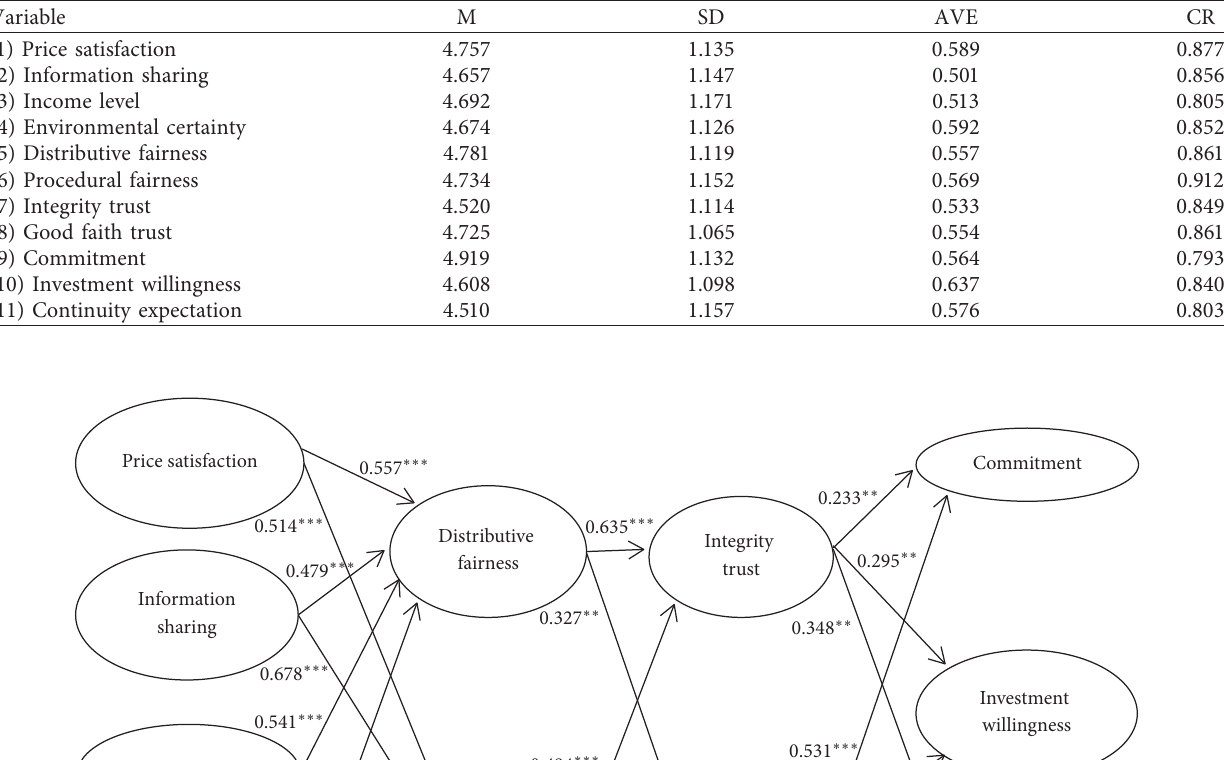
Table 3: Model adaptability.